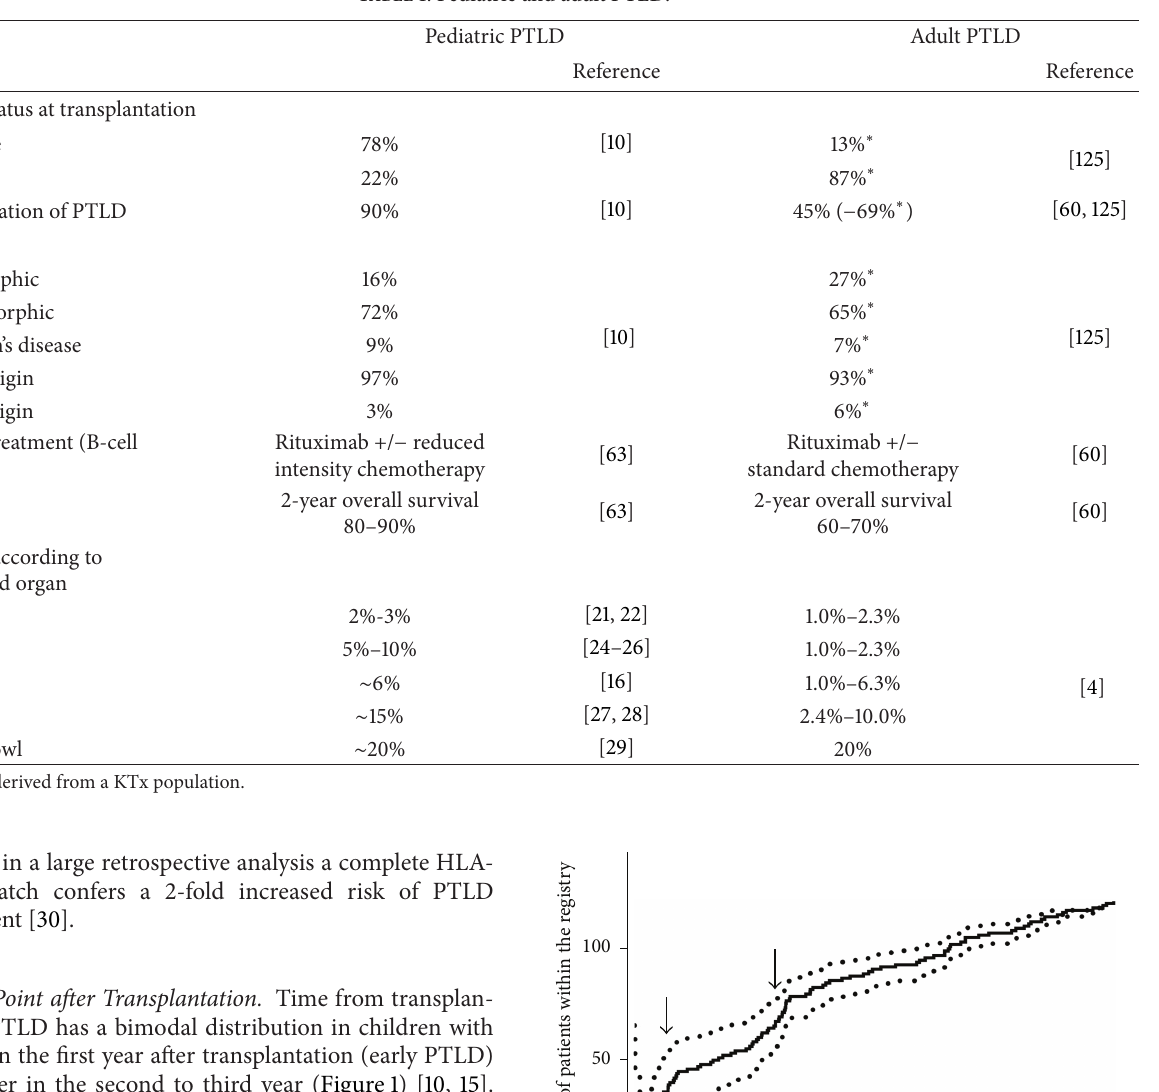
Table 1: Pediatric and adult PTLD.